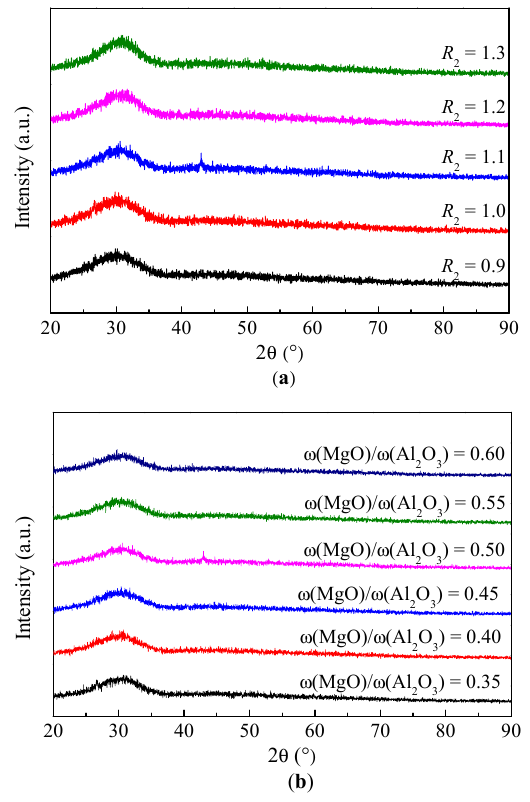
Figure 1. XRD results with the various R 2 ( a ) and ω (MgO)/ ω (Al 2 O 3 ) ratios ( b ).